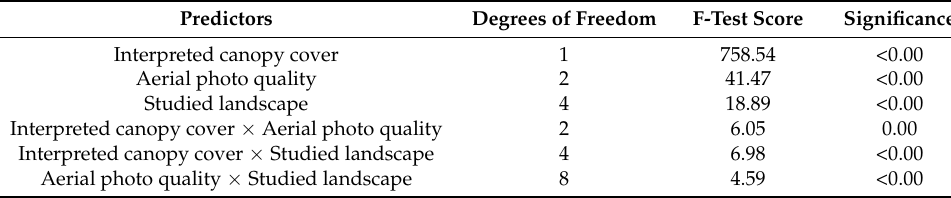
Figure A1. Models between tree diameter and crown projection for: Pinus sylvestris ( A ); Picea abies ( B ); Betula pubescens ( C ); Picea mariana ( D ); and Abies balsamea ( E ). For Betula papyrifera , models for Betula pubescens were used. Redrawn from [9]. Table A1. Analysis of variance table for testing the pairwise interactions between the interpreted canopy cover, aerial photo quality (oldest, middlemost or newest aerial photograph, proxy for photo quality), and the studied landscape.